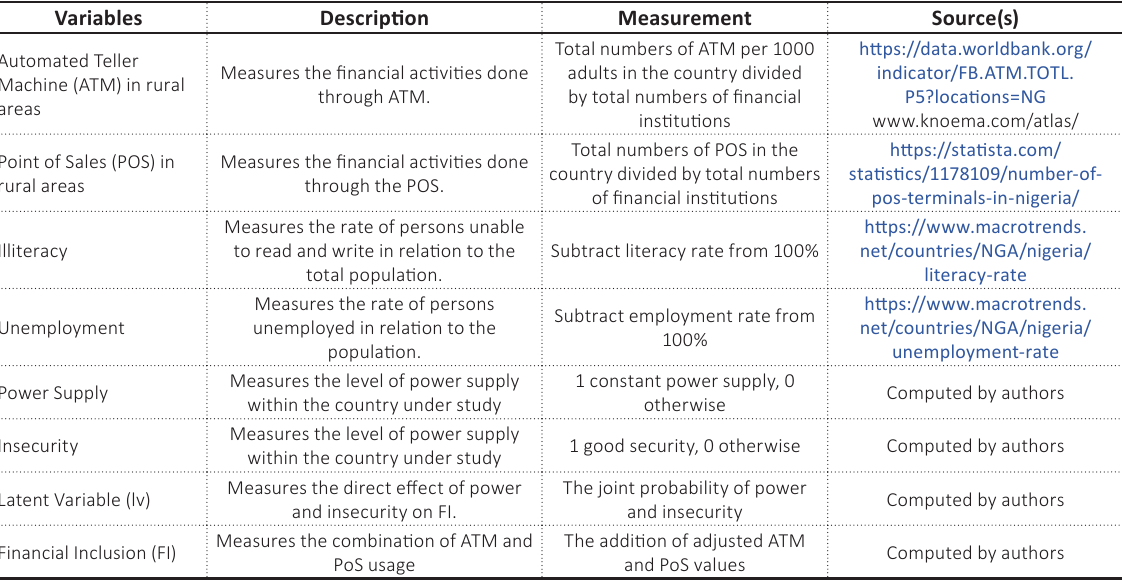
Table 1. Variables, description, measurement and